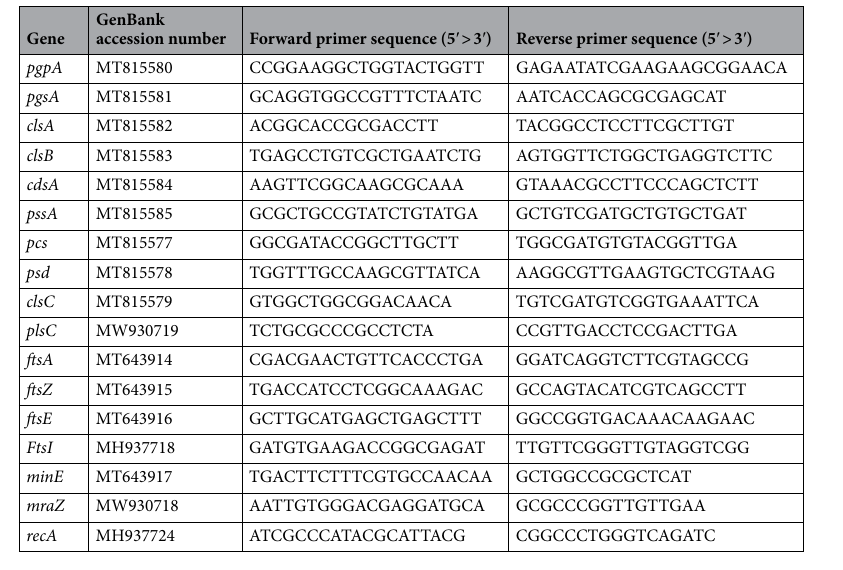
Table 1. List of primers used for qRT-qPCR